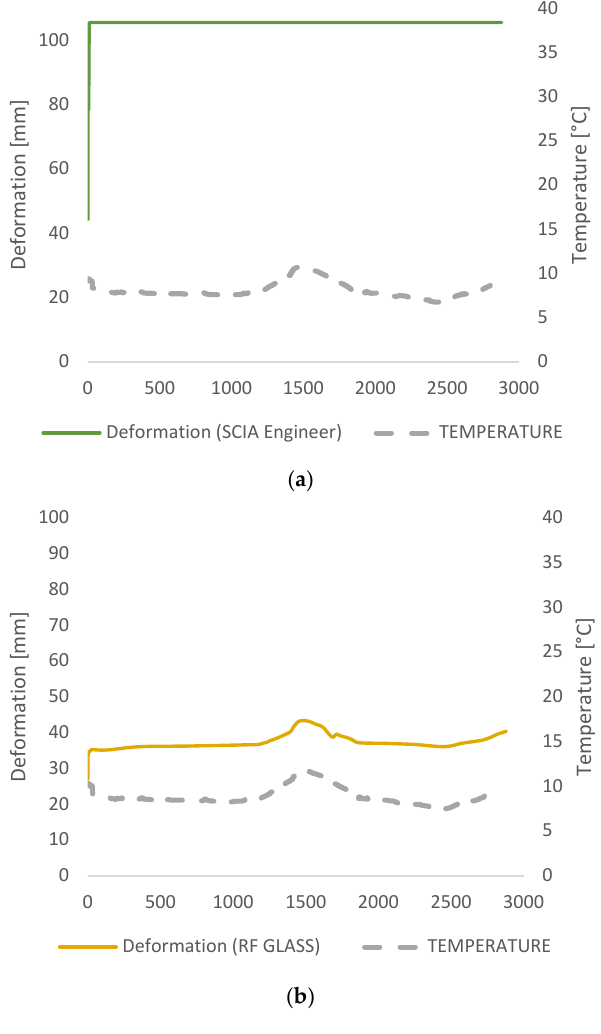
Figure 16. Deformation from different software FEM analysis: ( a ) SCIA Engineer; ( b ) RFEM—RF GLASS.